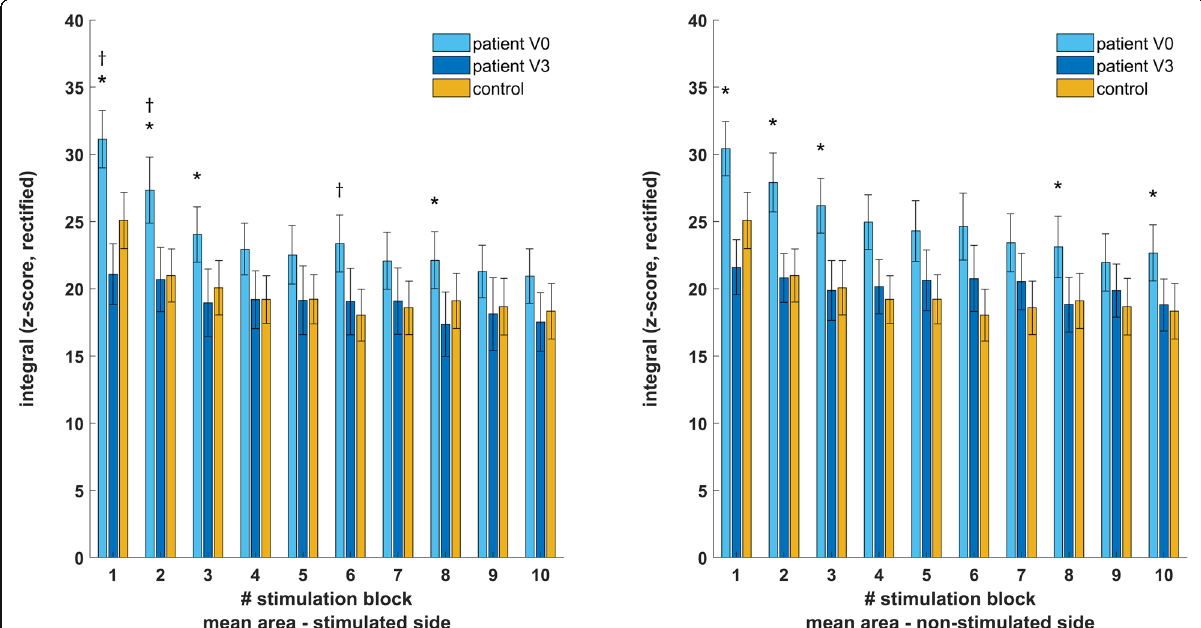
Fig. 2 blockwise comparison of nBR excitability in patients with migraine and controls. R2a is enhanced on the stimulated and non-stimulated side in migraineurs at V0, however only changes on the stimulated were significant given the high variance. These indicators of excessive brain stem excitability normalize after three months of treatment with CGRP mAbs and are then statistically indifferent from controls. * - indicates statistically significant difference between V0 and V3 in migraine. † - indicates statistically significant difference between V0 and